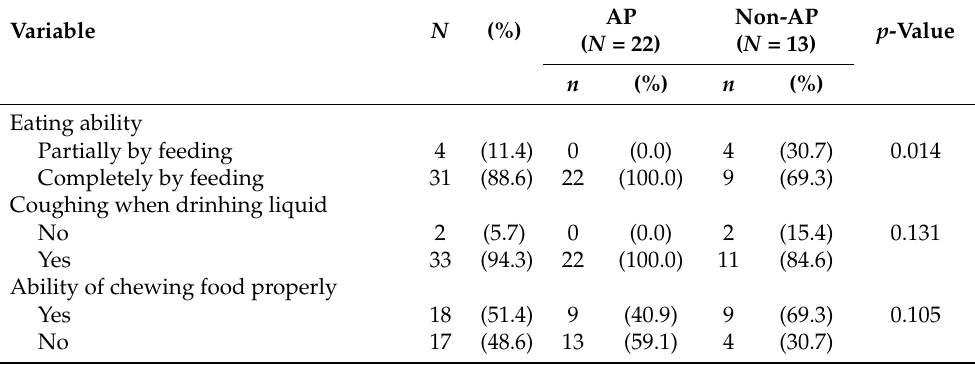
Table 3. Relationship between intake status and aspiration pneumonia of the participants of nasogas- tric feeding with combined oral